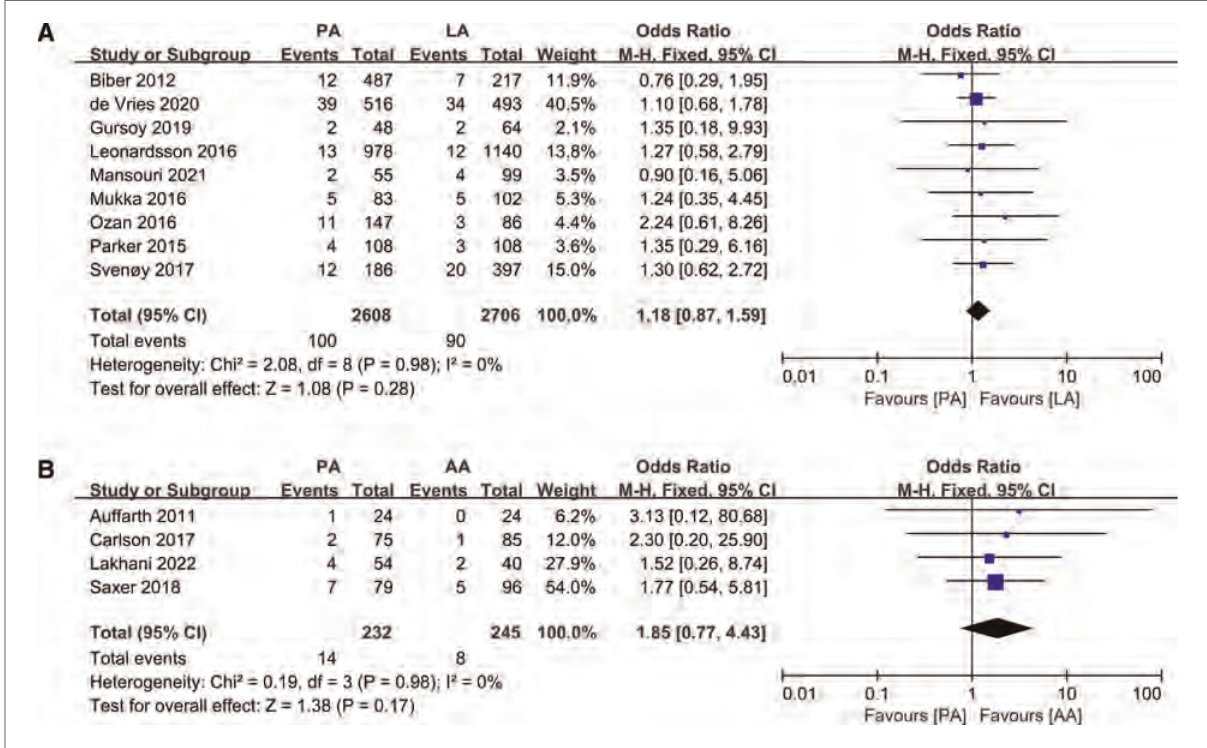
FIGURE 7 Forest plot comparison of wound infections. ( A ) Posterior approach and lateral approach, ( B ) Posterior approach and anterior